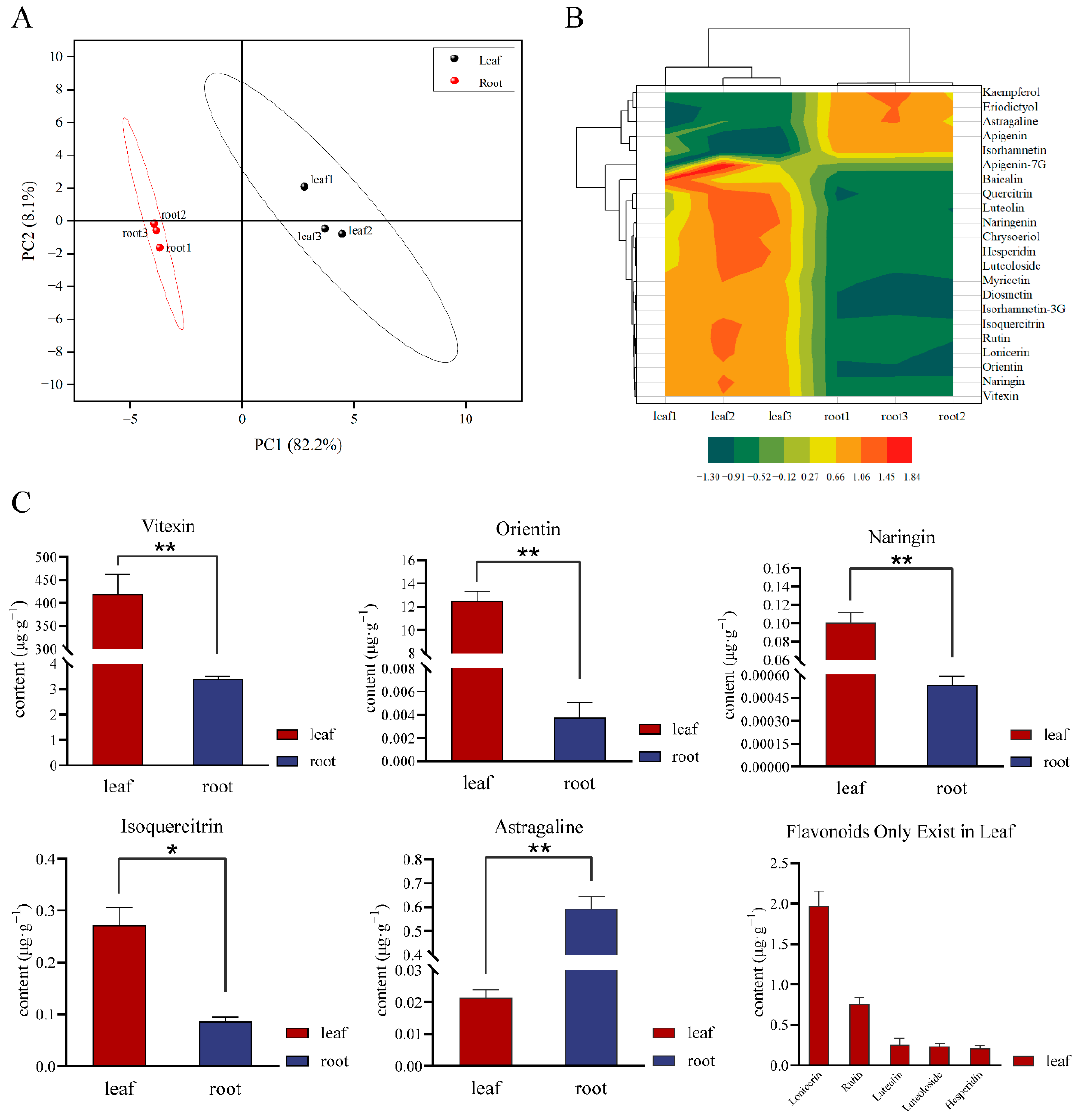
Figure 1. Metabolomic sequencing analysis of flavonoids. ( A ) PCA score plot of leaves and root tubers of T. hemsleyanum ; ( B ) Cluster contour heatmap of 22 metabolites; ( C ) Concentration of flavonoid active ingredients in different parts of T. hemsleyanum ; ( D ) Flavonoids only existing in leaves. (Concentration of flavonoids in leaves or root tubers more than 0.1 µ g · g − 1 ; different symbol means, * represents p ≤ 0.05, ** represents p ≤ 0.01.)